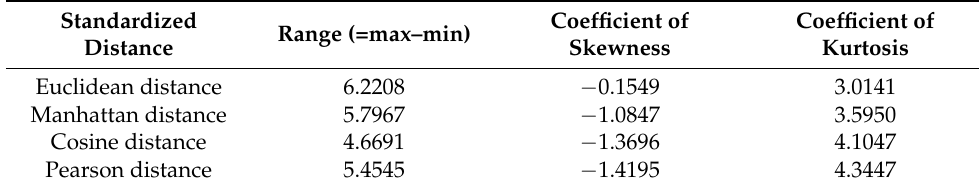
Table 4. Descriptive statistics for each vector